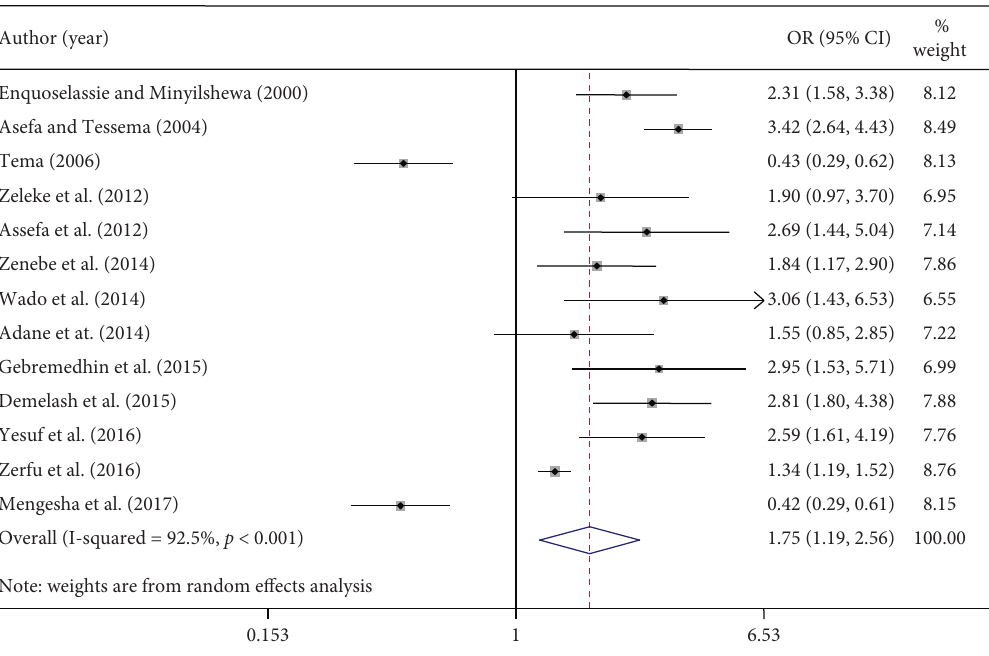
Figure 8: Forest plot displaying the association of rural residence and low birth weight in Ethiopia. Table 3: Meta-regression analysis of the different study-level covariates explaining possible sources of heterogeneity. Study